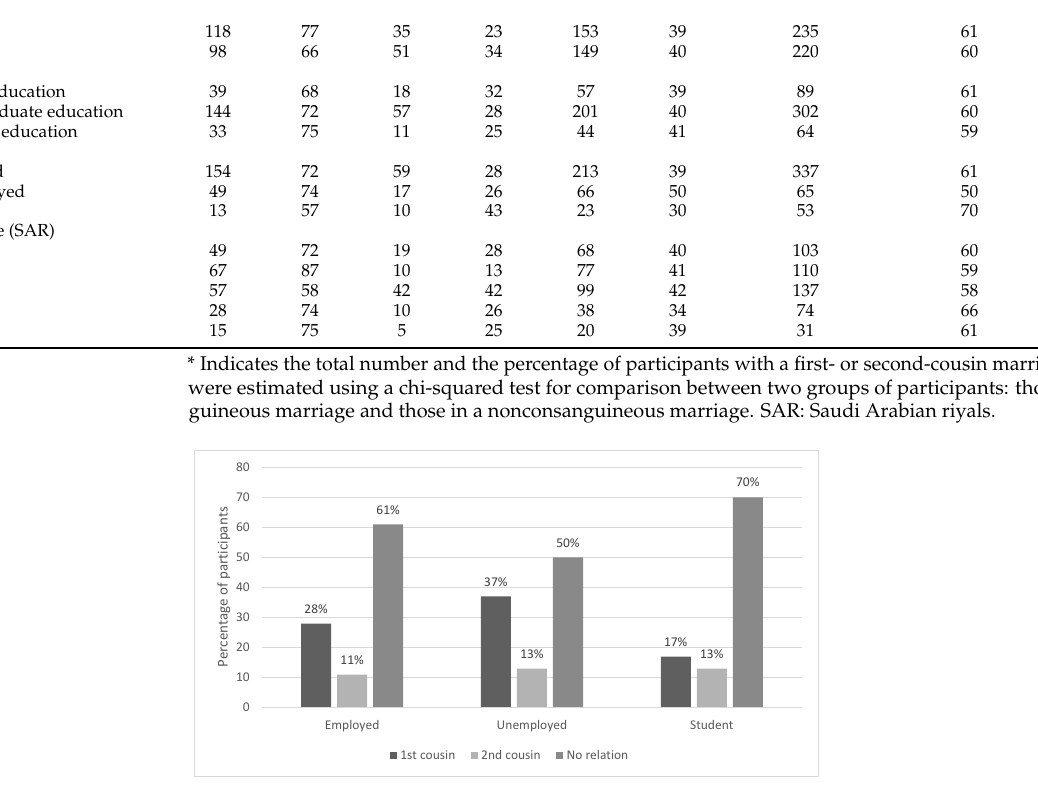
Figure 1. Comparison of prevalence of CM among Saudi citizens in Albaha according to employment status.